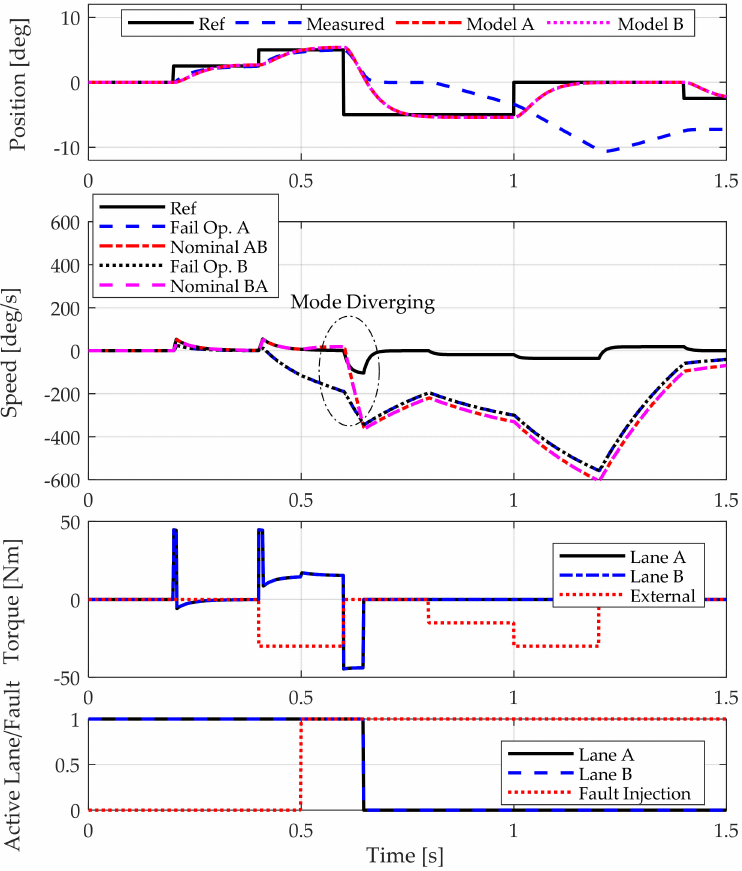
Figure 23. Example of a fail safe after a cross-lane fault, fault ID = 30 in Table 3.